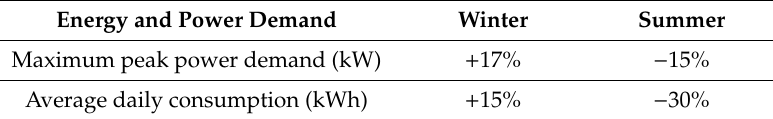
Table 3. Energy and power demand variation due to the green roof presence.